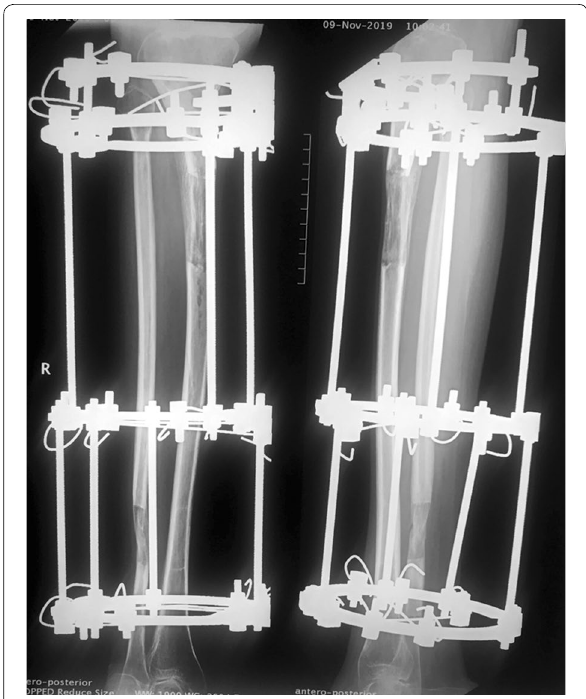
Fig. 1 Tibial lengthening case showing that the regeneration develops along the axis of the applied